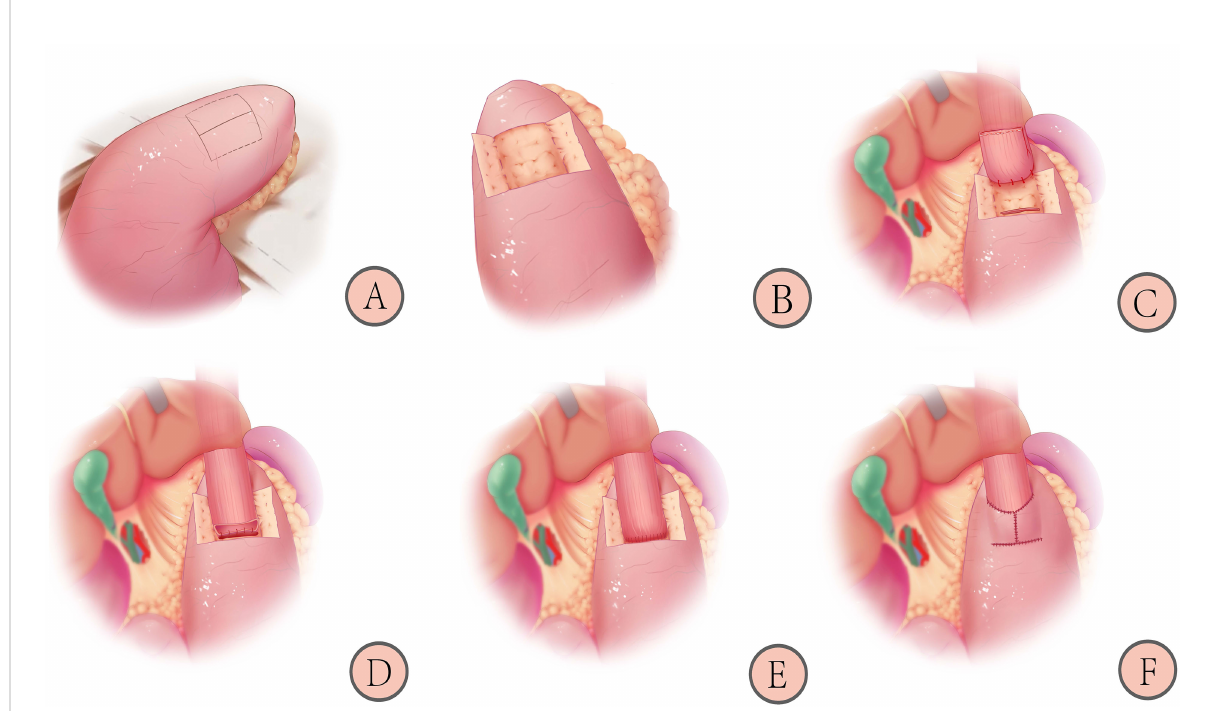
FIGURE 3 Schematic diagram of reconstruction after proximal gastrectomy with the double- fl ap technique: 1) Marking the “ H ” -shaped mucosal window (A) ; 2) Making the double- fl ap (B) ; 3) Fixing the esophagus and opening the gastric mucosal window (C) ; 4) Completing continuous hand suture (D, E) ; 5) Covering the double- fl ap and suturing with barbed wires (F)